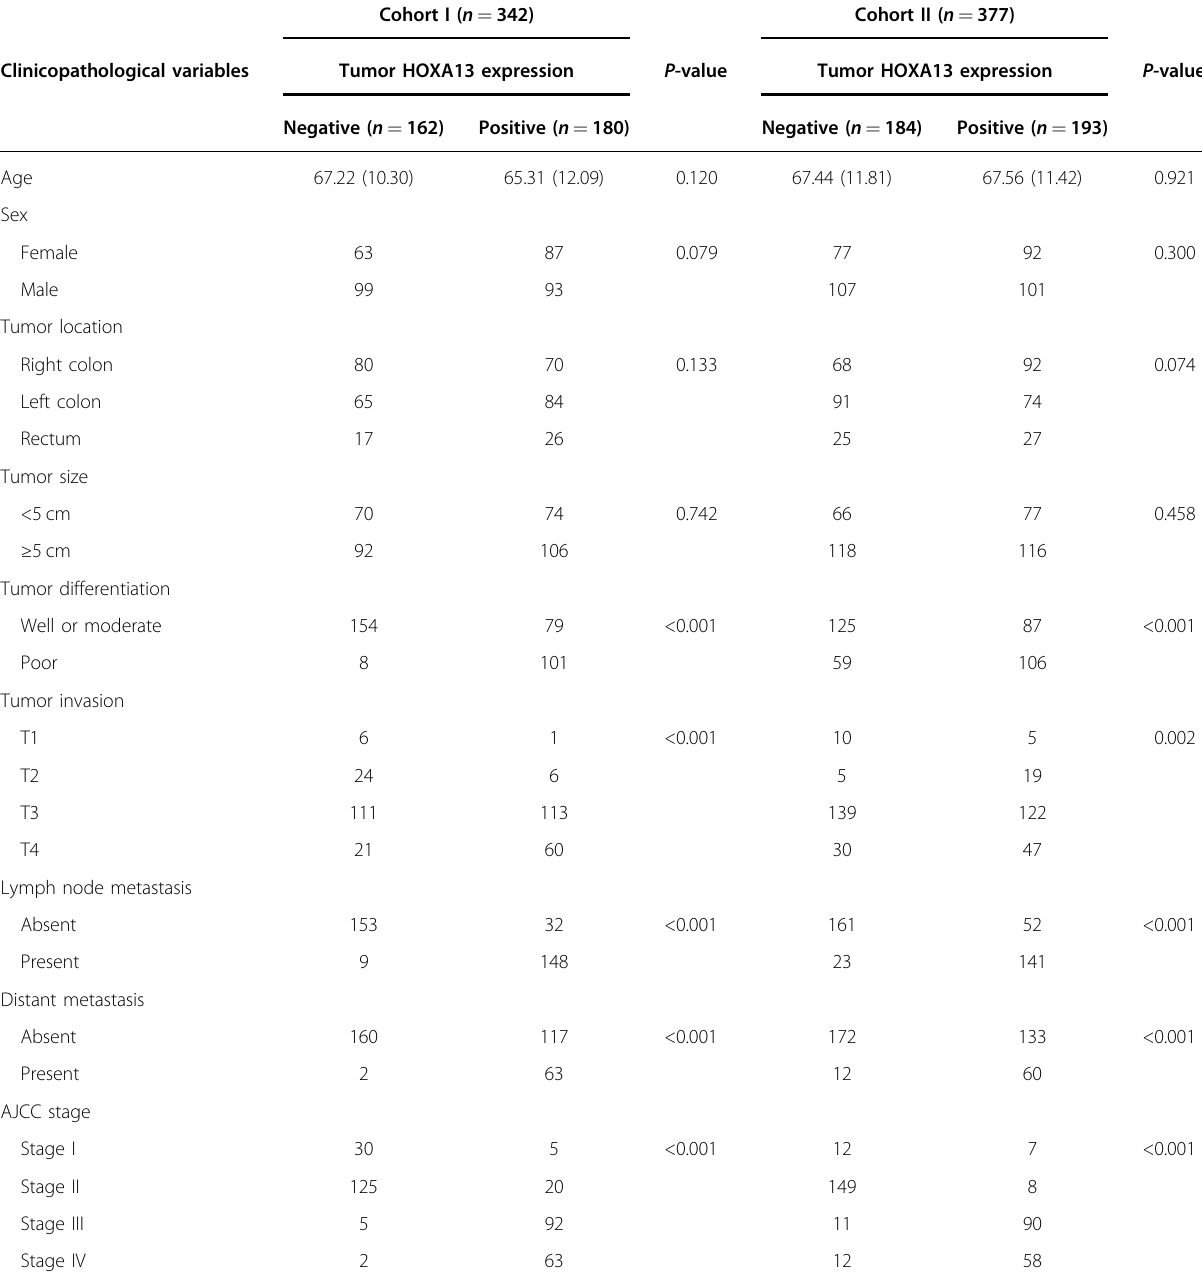
Table 1 Correlation between HOXA13 expression and clinicopathological characteristics of CRC in two independent cohorts of human CRC